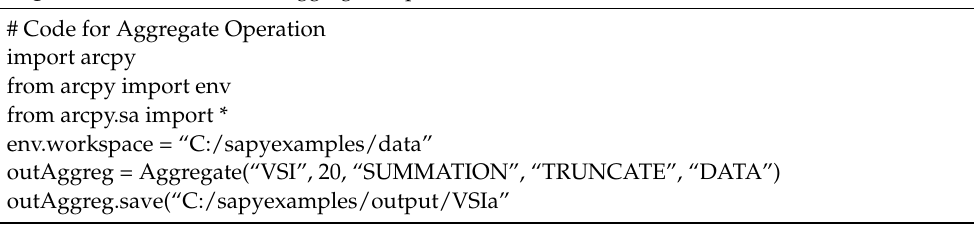
Algorithm 1: The Code for Aggregate Operation